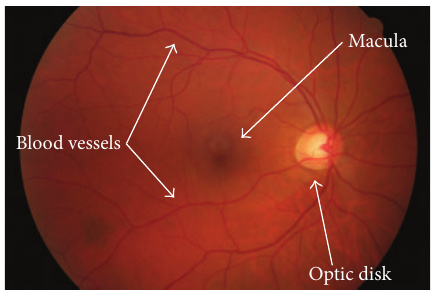
Figure 1: An example of eye-fundus image: the macula is shown in the middle, the optic disk is to the right, and the blood vessels are entering and leaving the eye through the optic